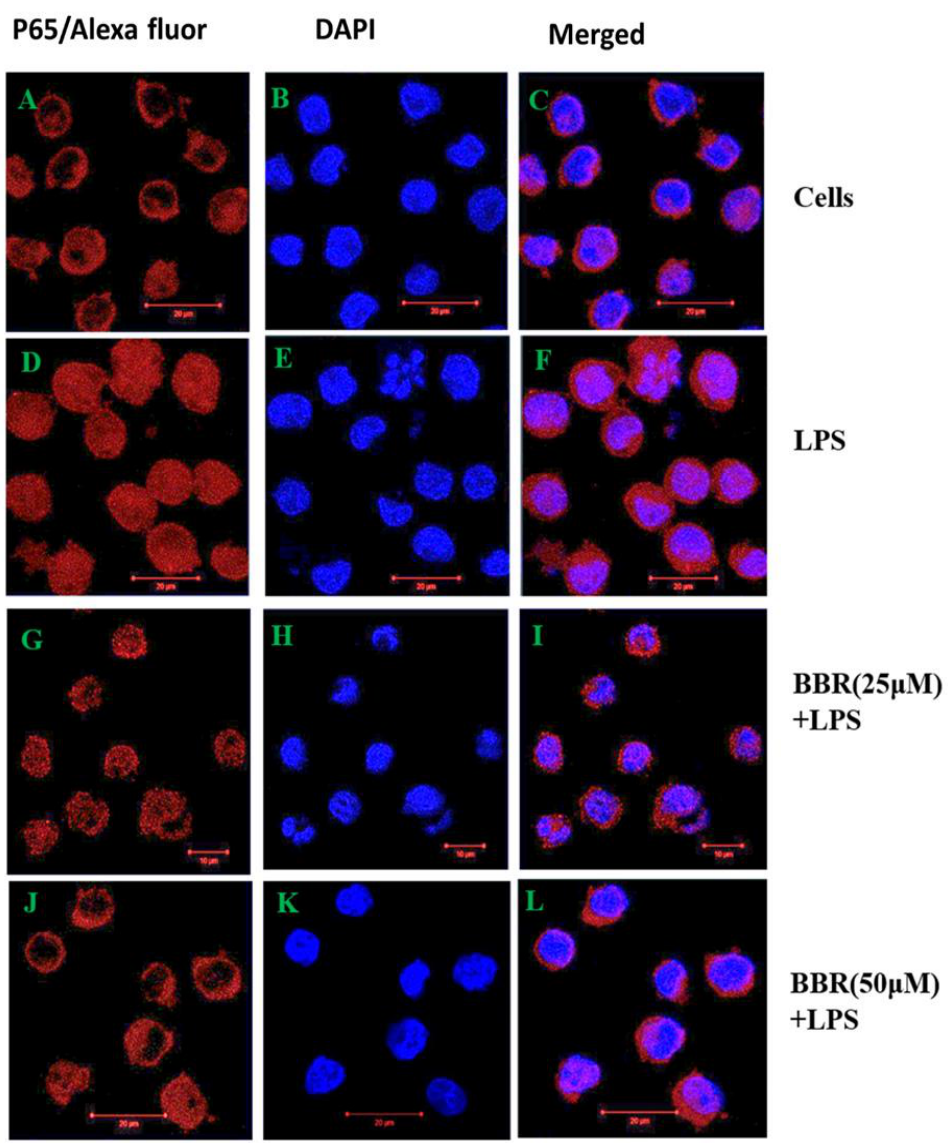
Figure 5. Effect of BBR on LPS-induced NF- κ B P-65 subunit translocation. THP-1 cells were pretreated with BBR (25 and 50 µ M) then induced with LPS (0.5 µ g/mL), and the subcellular localisation of the p65 subunit was determined by the immunofluorescence technique. The NF- κ B p65 subunit was stained with Alexa Fluor 594 conjugated secondary antibody and the nucleus was counterstained with DAPI. Images were captured under a confocal microscope (Zeiss, Germany). ( A , D , G , J ) are Alexa Fluor labelled cells; ( B , E , H , K ) are DAPI stained cells and ( C , F , I , L ) are merged images of Alexa Fluor and DAPI stained cells, respectively.